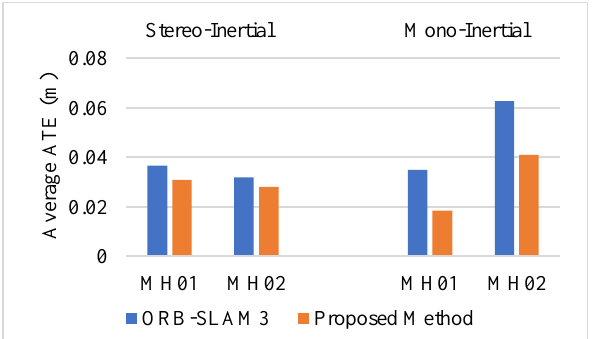
Figure 6. Average of ATE values in the two dataset.